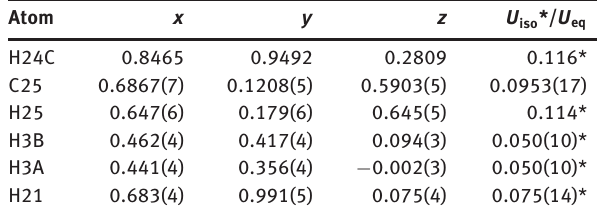
Table 2: Fractional atomic coordinates and isotropic or equivalent isotropic displacement parameters (Å 2